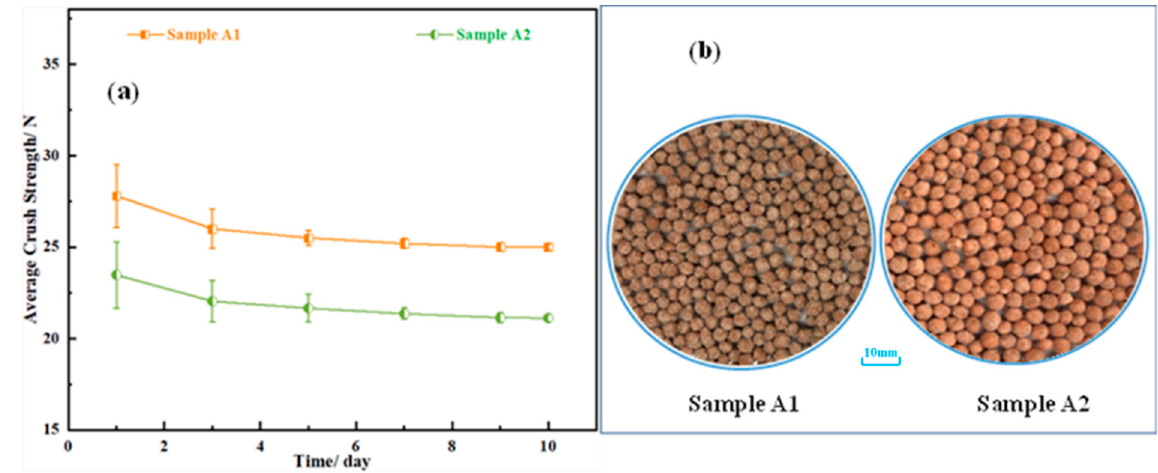
Figure 10. ( a ) Average crush strength of the granular rice fertilizer; ( b ) Appearance of the granular rice fertilizer.